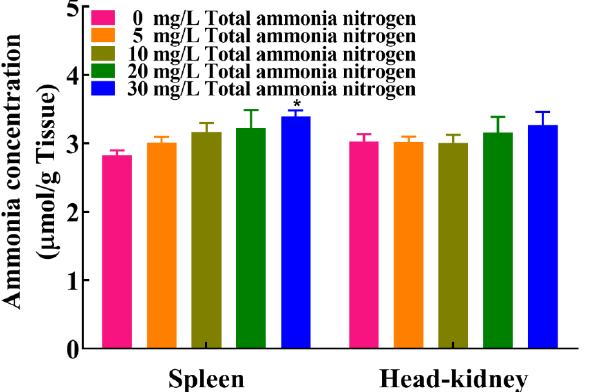
Figure 1. Effects of chronic ammonia exposure on ammonia accumulation in the spleen and head-kidney of M. amblycephala . Each column represents mean ± SE of six duplicates. The values of p < 0.05 are represented as “*” above the column, indicating significant difference versus control, respectively.